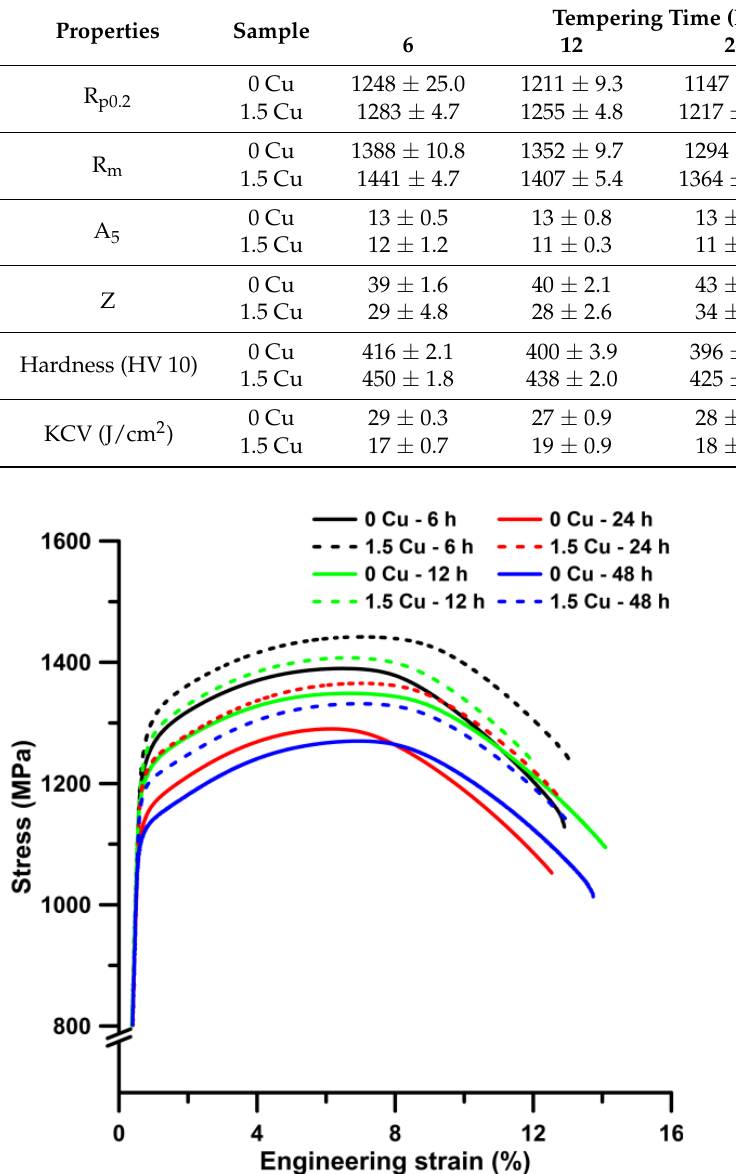
Table 2. Summary of mechanical properties—tensile yield strength (R p0.2 ), ultimate tensile strength (R m ), total plastic elongation (A 5 ), reduction of area (Z), and hardness and Charpy impact tough- ness (KCV).